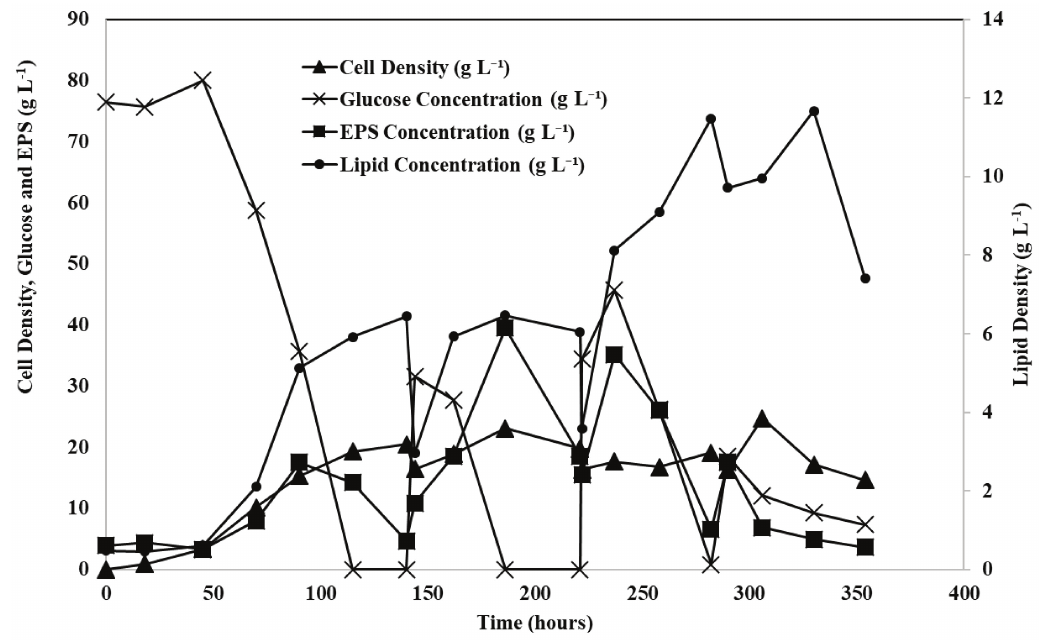
Fig. 1 – Cell density, lipid concentration, glucose concentration, and polysaccharide production by L. starkeyi during repeated fed-batch cultivation in the MM with